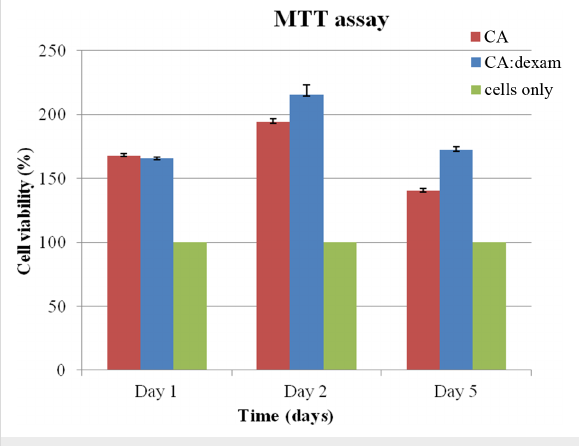
Figure 8: MTT assay of L929 cells with the examined scaffolds after 1, 2 and 5